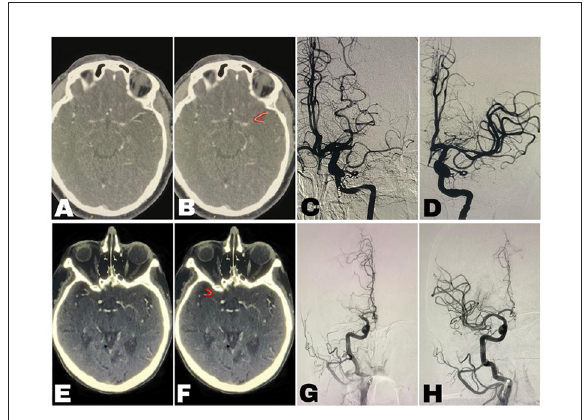
FIGURE2 Imaging of two patients [ (A–D) patient-1, (E–H) patient-2]. (A,E) The “Tilted-V Sign” unmarked. (B,F) The “Tilted-V Sign” (marked in red)—axial images of CT angiogram of the head showing filling of both proximal M2 segments of the Middle Cerebral Artery (MCA) distal to an occluded, not visualized M1-MCA segment, thereby creating a Tilted-V shape. (C,G) Digital subtraction angiography (DSA) before endovascular thrombectomy (EVT) showing complete occlusion of the M1-MCA segment but without visualization of vessels distal to the occlusion. (D,H) DSA following EVT showing successful recanalization.